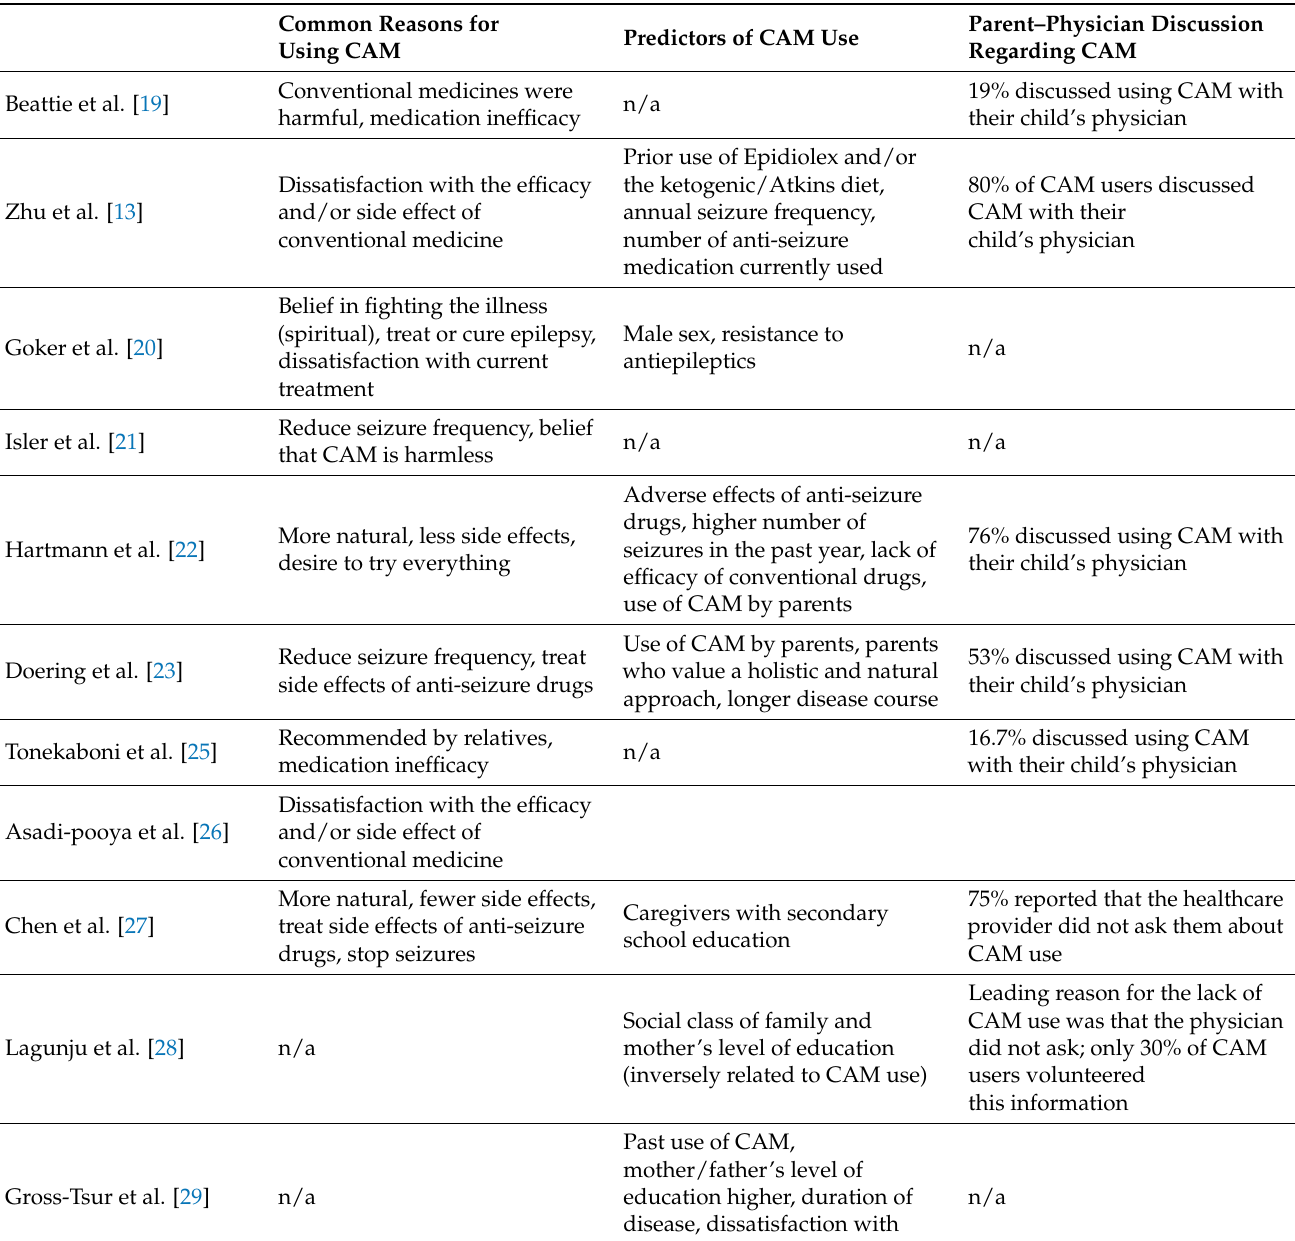
Table 2. Reasons for using CAM, predictors of CAM use, and parent–physician discussions regarding CAM